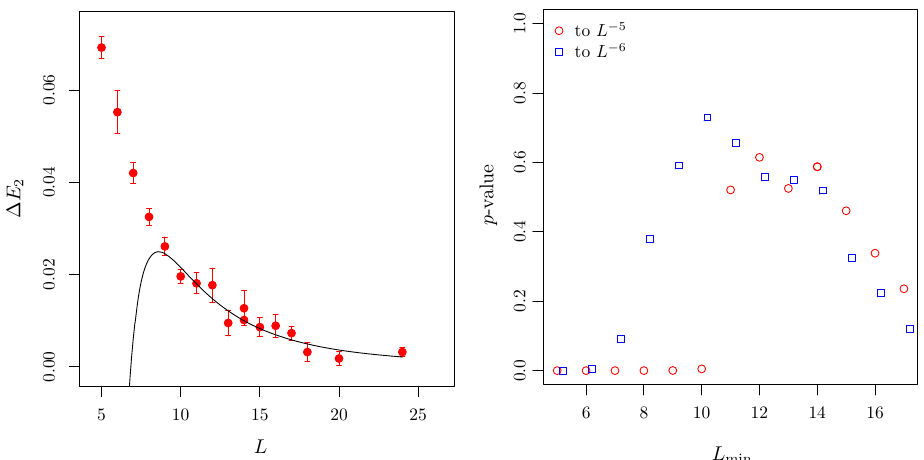
Fig. 4 Left: fit of Eq. (20) to the data for (cid:7) E 2 in the L -range [ 9 , 24 ] including a and r as fit parameters. Right: p -value of the fit of Eq. (20) to the data for (cid:7) E 2 as a function of L min with a constant L max = 24